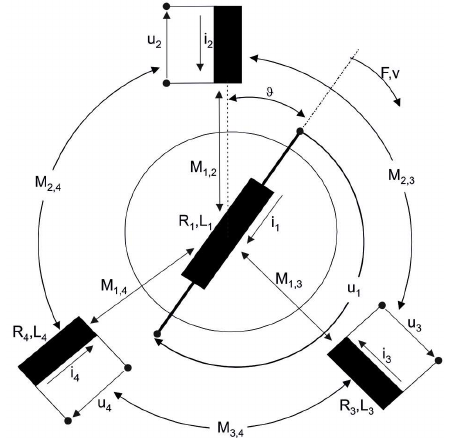
Figure 1. Lumped element representation of a three-stator phases and one-rotor phase SM.